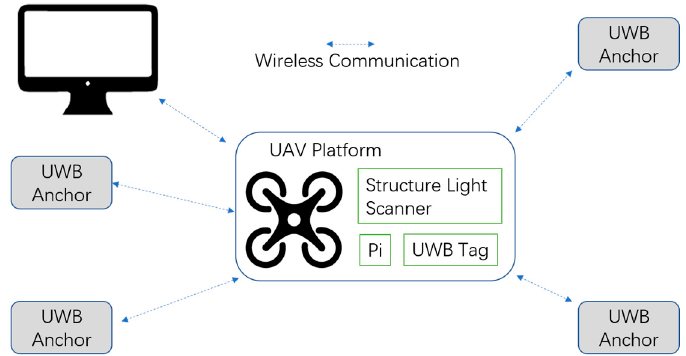
Figure 2. Hardware setup.